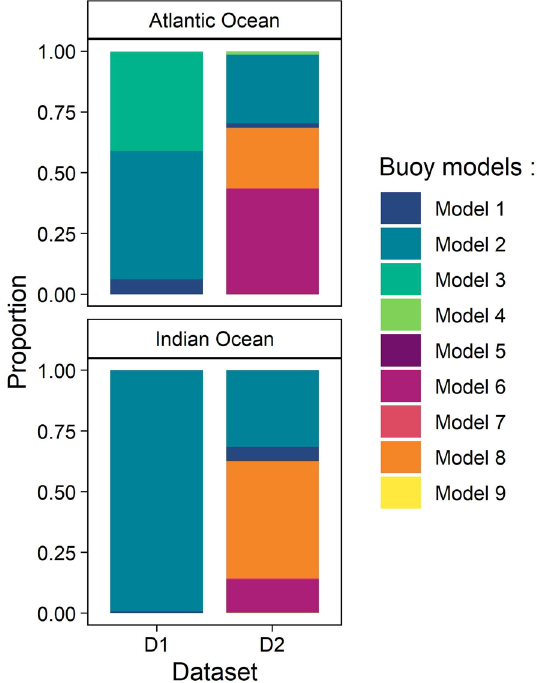
Fig. 1. Proportion of buoy model constituting the D1 and D2 datasets in the Atlantic and Indian Oceans.